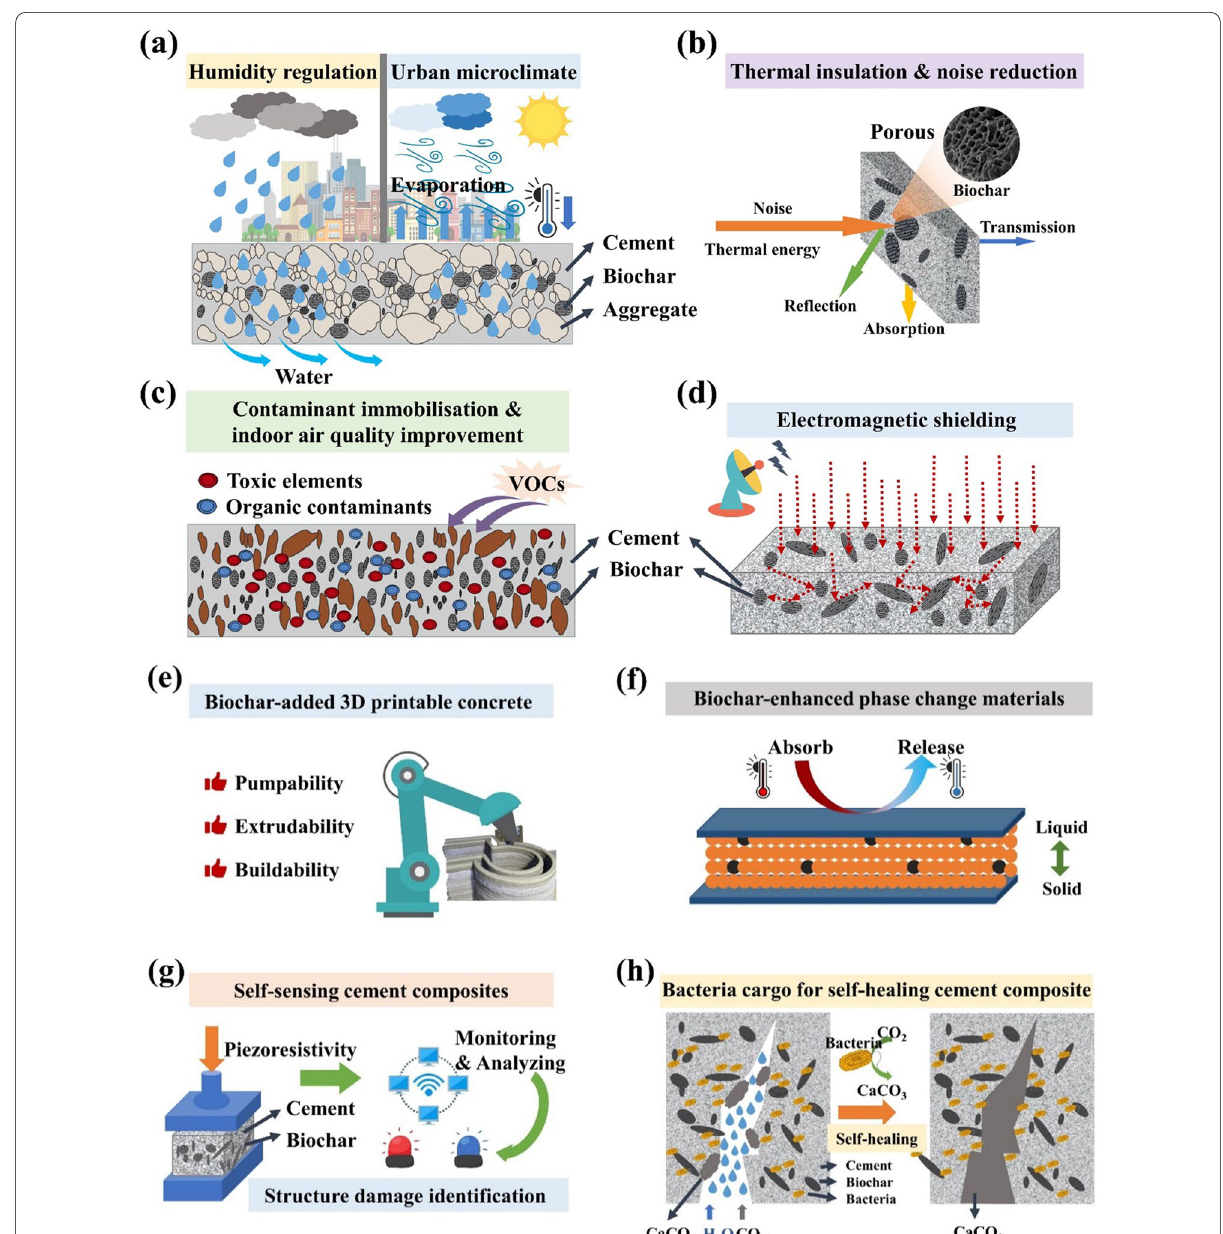
Fig. 5 Environmental and technical advantages of biochar composites: a humidity regulation and urban microclimate; b thermal insulation and noise reduction; c contaminant immobilisation and indoor air quality improvement; d electromagnetic shielding; e biochar-added 3D printable concrete; f biochar-enhanced phase change materials; g self-sensing cement composites; h bacteria cargo for self-healing cement